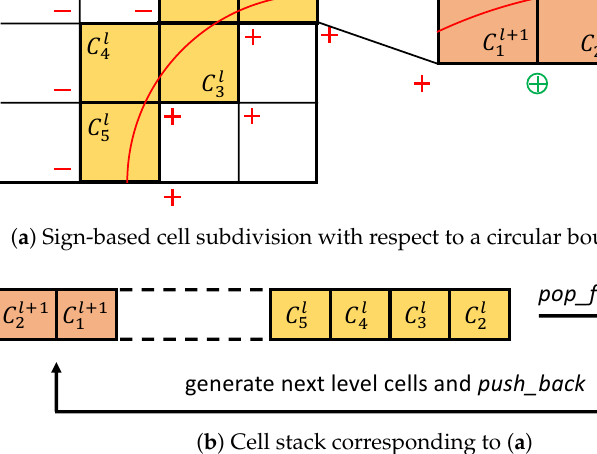
Figure 14. Illustration of the sign-based refinement algorithm: ( a ) the cut cells in level l are subdivided into appropriate sub-cells. The new cut cells in level l + 1 are identified by the newly calculated (circled) signs and the previously obtained (not circled) signs, and then ( b ) pushed to the back of the stack to wait for the next level